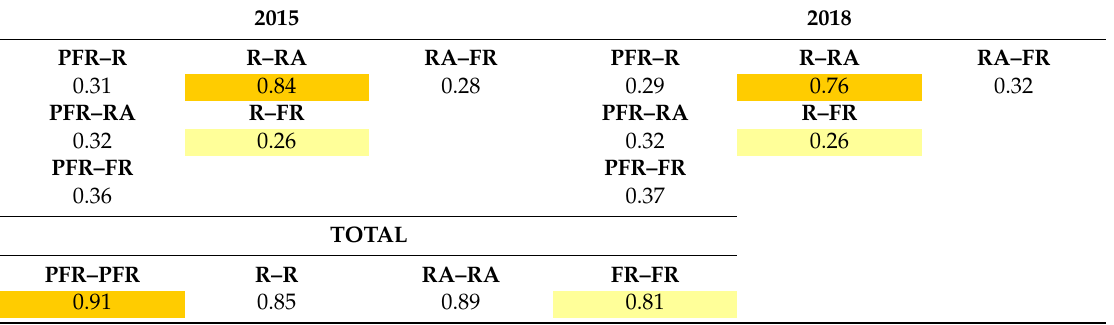
Table 5. The Jaccard’s species similarity coefficient for shore sectors of Lake Piaseczno in 2015 and 2018 (extreme values are marked with colours: yellow, min; orange, max).